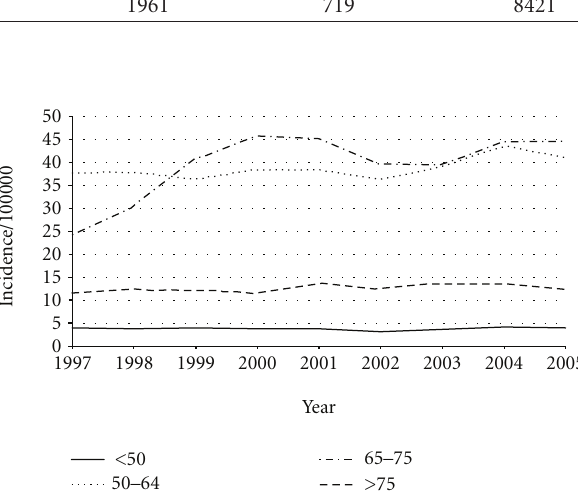
Figure 1: Incidence per 100 000 of DCIS in the